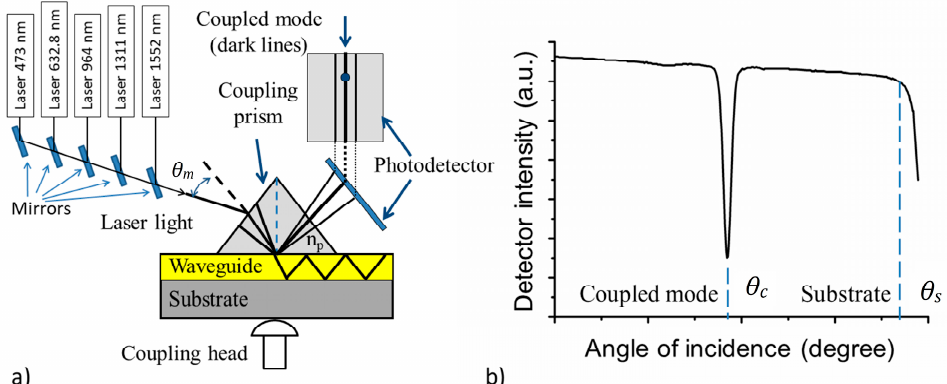
Figure 5. ( a ) A schematic view of the prism-coupling technique; ( b ) the assessment of the critical angle of incidence θ c (coupled mode) and θ S (substrate), used for the evaluation of the refractive index of the guiding mode for planar optical waveguides [27].